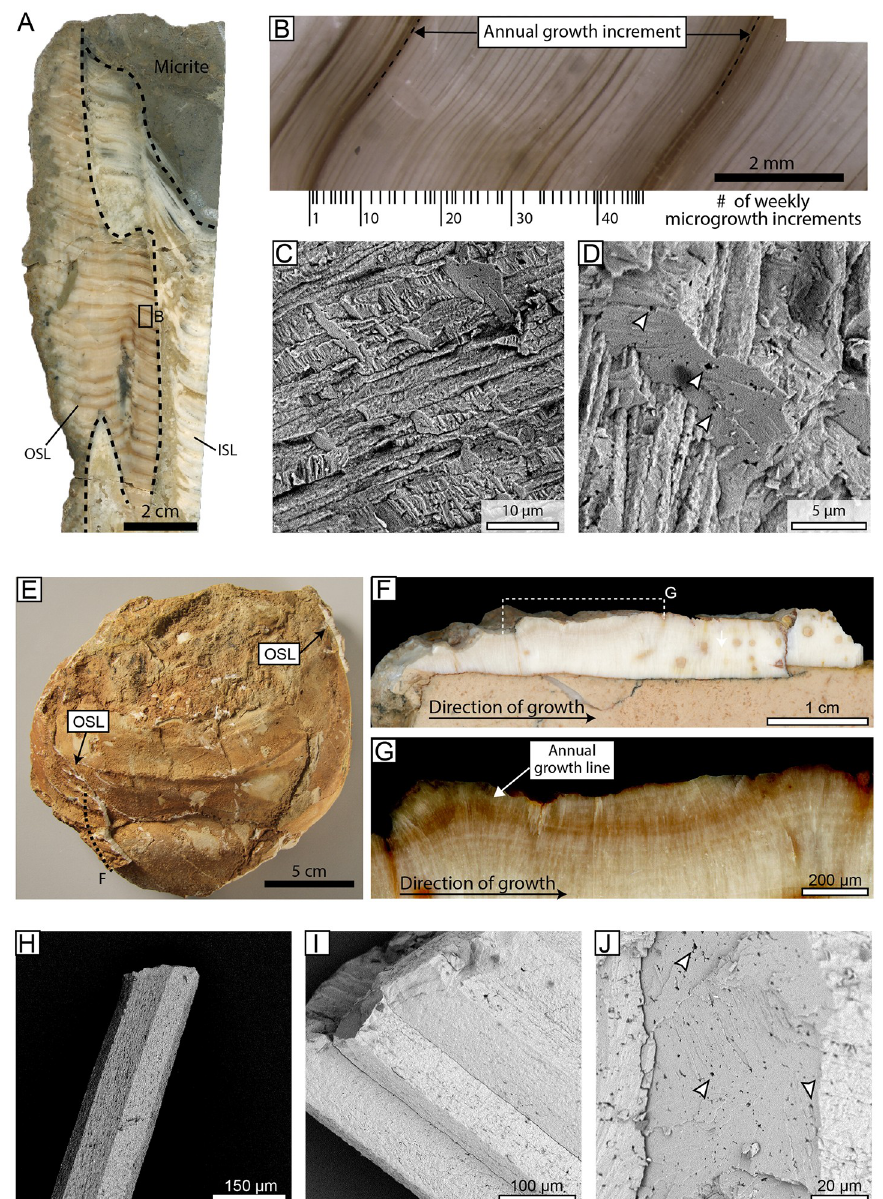
Fig 2. The studied shell material. (A) Cross-section trough the Hippurites resctus shell from the ‘Atzl Reef’ deposits of Brandenberg (Austria) showing marked annual growth lines in the outer shell layer (OSL). (B) At higher magnification, microgrowth increments were easily recognizable. Their number within one annual growth increment (ca. 49) suggests weekly shell growth cycles for the studied H . resectus individual. (C) SEM imaging revealed the preservation of the original fibrous prismatic ultrastructure of the OSL and the presence of intra-prismatic voids inside the biomineral units. (E) One of the studied Inoceramus sp. fossils from the ‘lastame’ deposits of Sant´Anna d´Alfaedo (Italy). The inoceramid steinkern is partially covered by original OSL. The dotted line indicates the location of the shell cross-cut depicted in (F). In cross-cut very faint annual growth lines were recognized (F), however, these became more visible after increasing the contrast of the images (G). Under the SEM, the low-Mg calcite prisms of the studied inoceramids displayed smooth surfaces and sharp edges (H) and the absence of neomorphic precipitates between adjacent prisms. (J) The inoceramid prisms also displayed intra-prismatic voids, which were originally filled with organic matrix. ISL = inner shell layer.